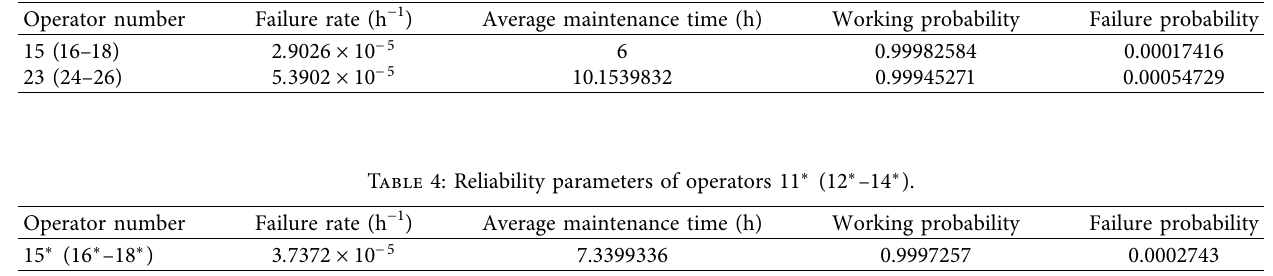
Table 3: Reliability parameters of operators 15 (16–18) and 23